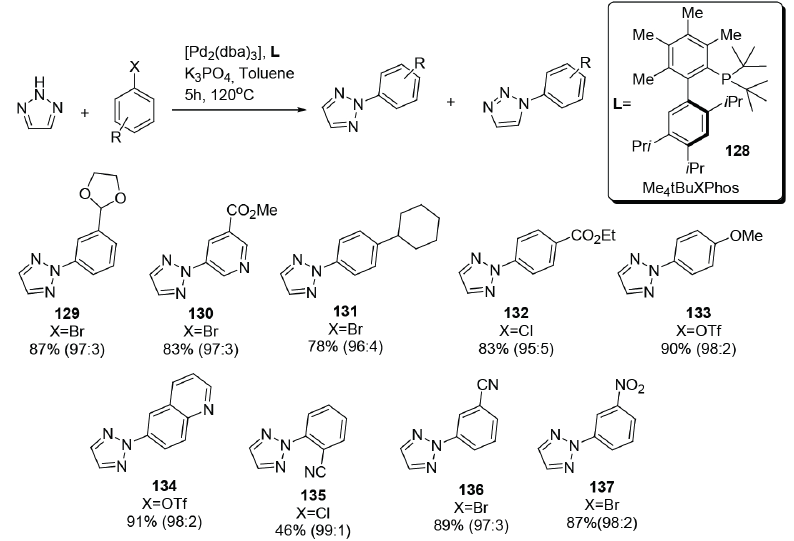
Figure 20 - The Palladium Catalyzed N2-regioselective Arylation of